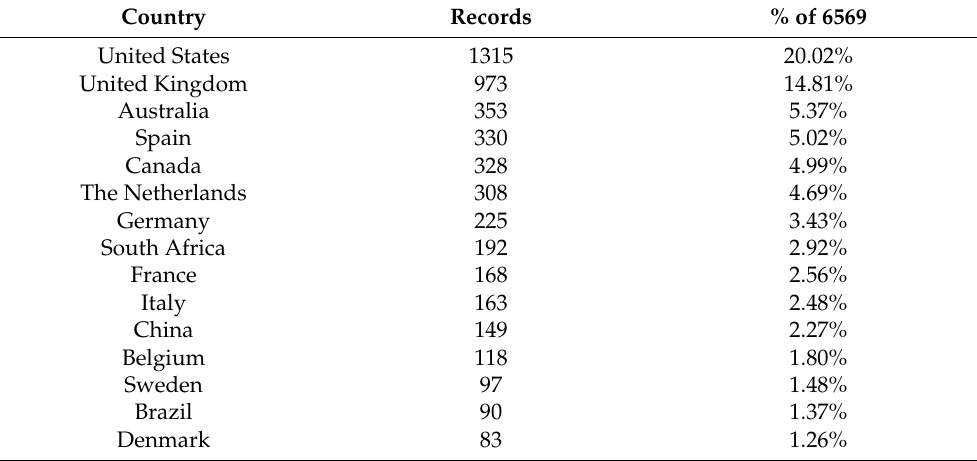
Table 1. Top 20 countries for research on “social cohesion”. Multiple countries are possible for each